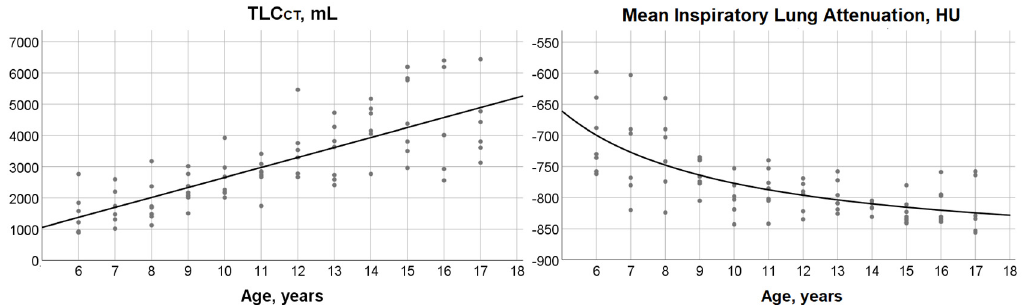
Figure 3. Left panel: Scatterplot and fit line depicting the significant linear association between total lung capacity measured by computed tomography scan (TLC CT ) and age (r 2 = 0.59; p < 0.0001). Right panel: Scatterplot and fit hyperbola curve describing the significant relationship between mean inspiratory lung attenuation and age (r 2 = 0.48; p < 0.0001). Dots correspond to measured values for individual subjects.